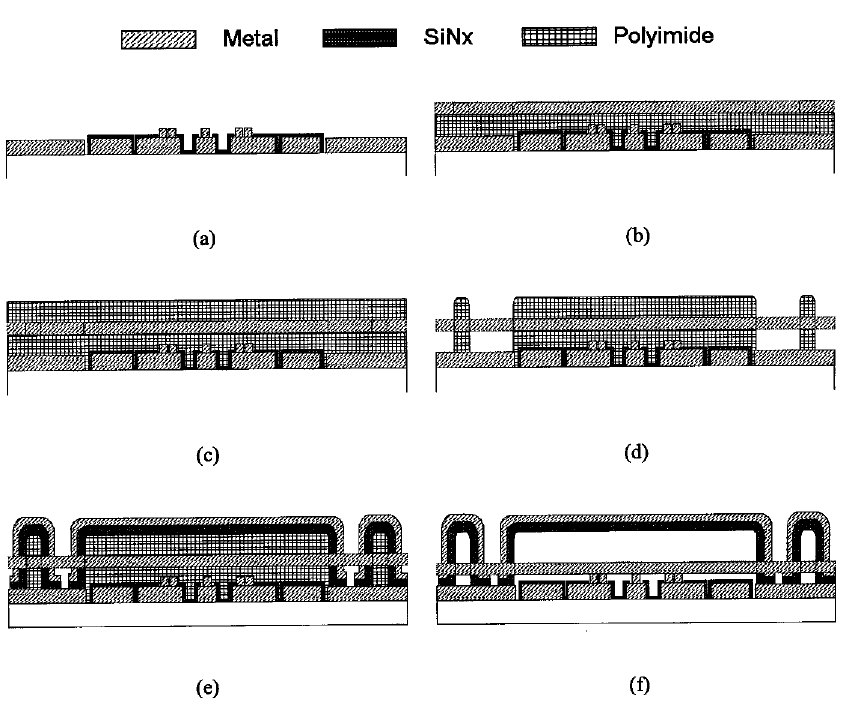
FIGURE 3 Hinged RF MEM switch